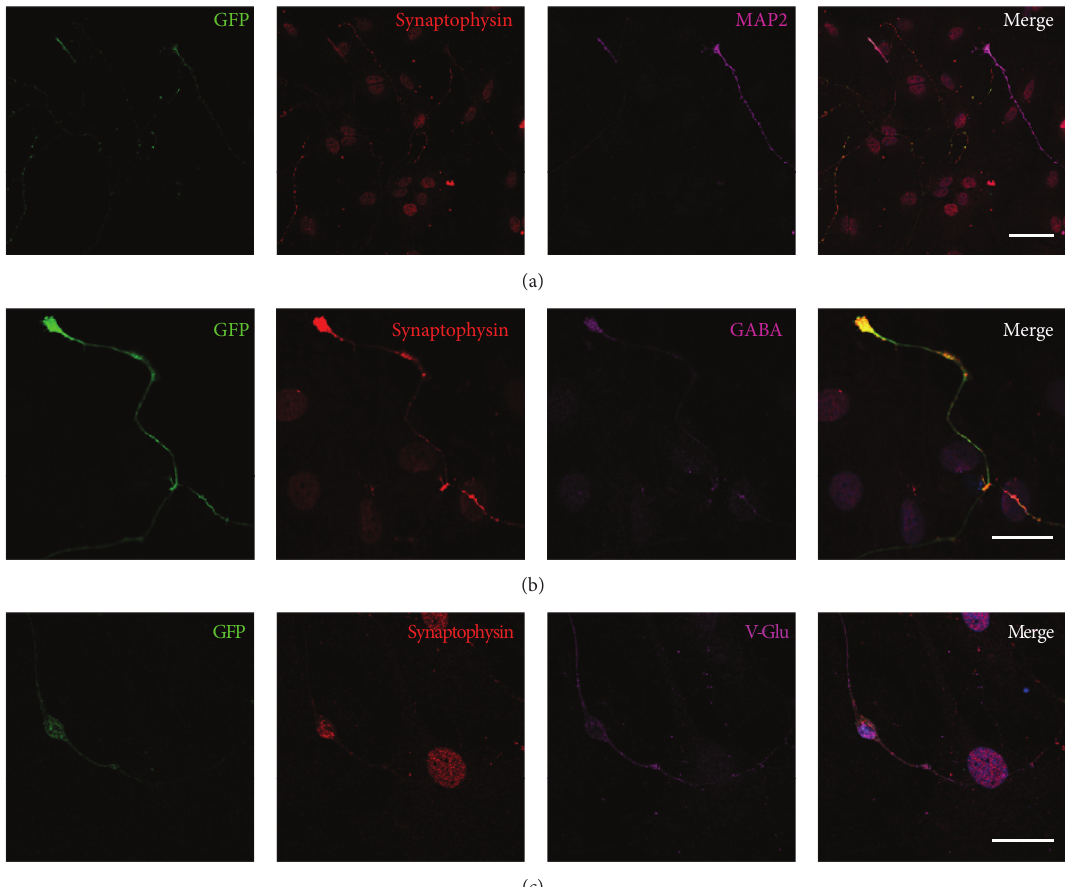
Figure3:TheiNcellsexpressedmatureneuronmarkersynaptophysin,GABA,orv-Glu.(a)Twenty-fourdaysafterDOXtreatment,theurine- iN cells expressed synaptophysin. (b) Immunofluorescent study revealed GABA positive iN cells. (c) Immunofluorescent study revealed that iN cells were positive for v-Glu. Scale bars, 50 𝜇 m (a) and 20 𝜇 m (b, c).